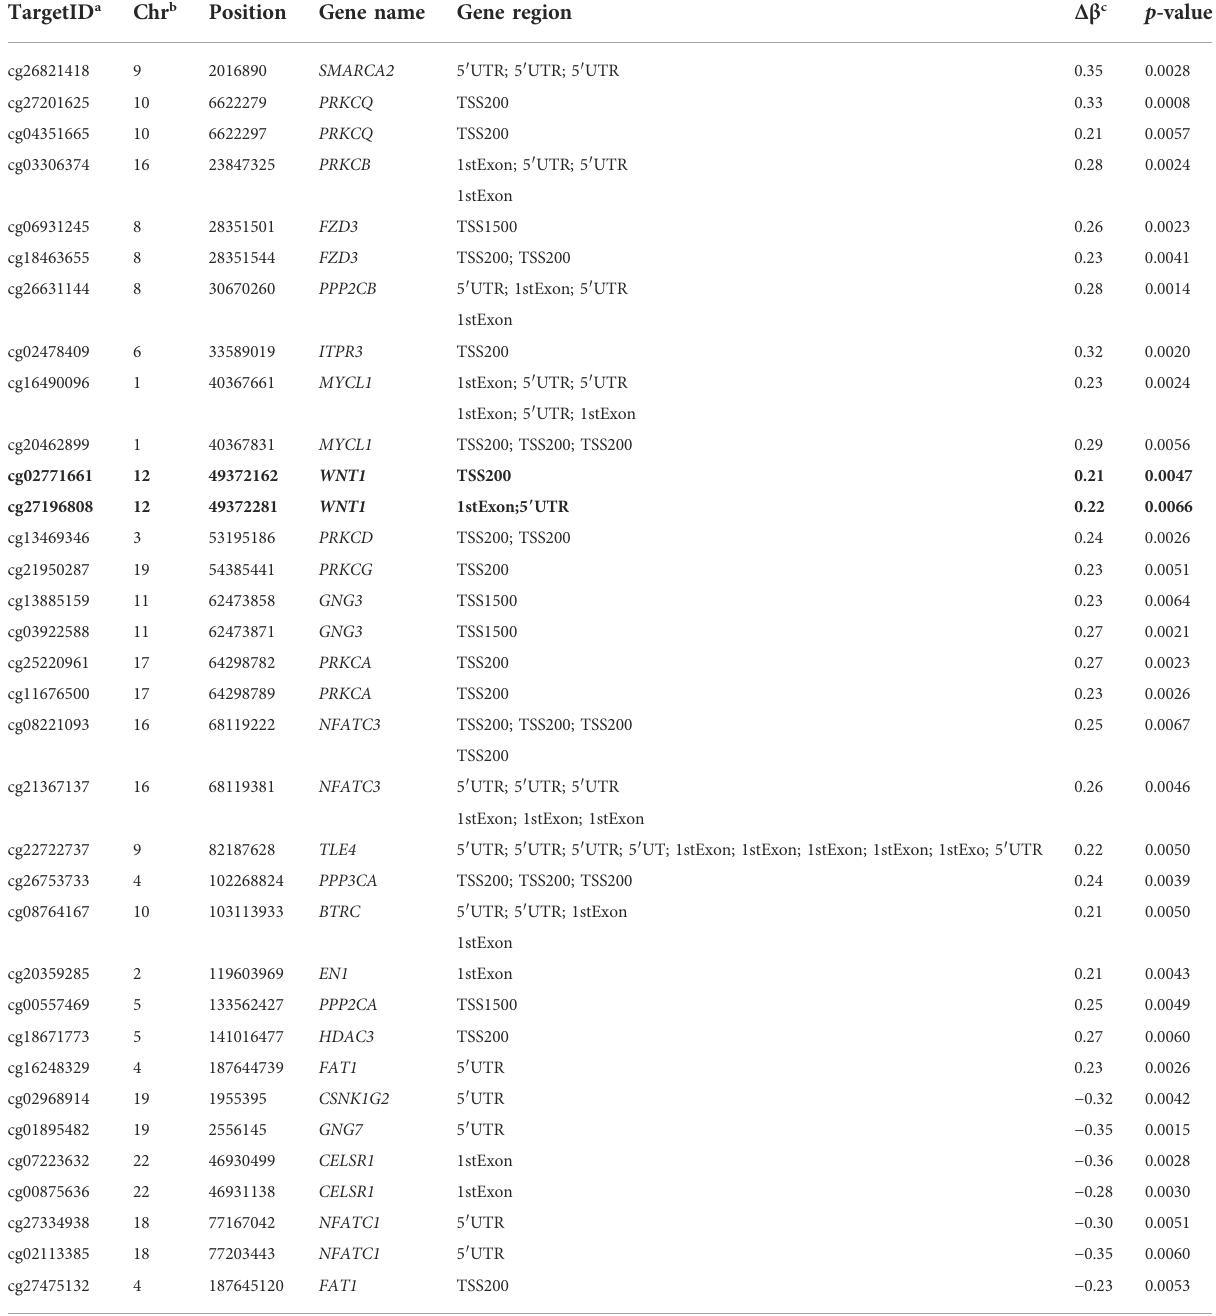
TABLE 1 The 34 CpGs of cfDNA episignature found in metastatic patients with luminal B breast cancer associated with the Wnt signaling